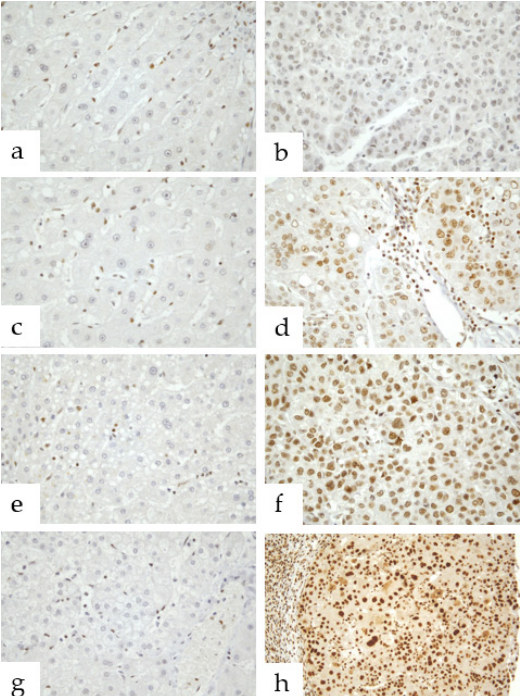
Figure 1. Immunohistochemical patterns of parafibromin expression in human liver tissues. ( a , c , e , g ) In matched non-tumor liver tissues, parafibromin was not expressed in hepatocytes at all (×400). ( b , d , f , h ) In representative images of tumor tissues, parafibromin was expressed weakly in the nuclei of some hepatocytes (( b ), ×400), strongly in <50% of hepatocyte nuclei (( d ), ×400), strongly in ≥ 50%